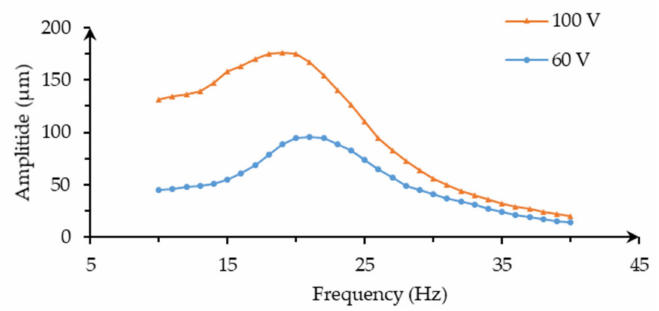
Figure 6. Curves of frequency and amplitude.